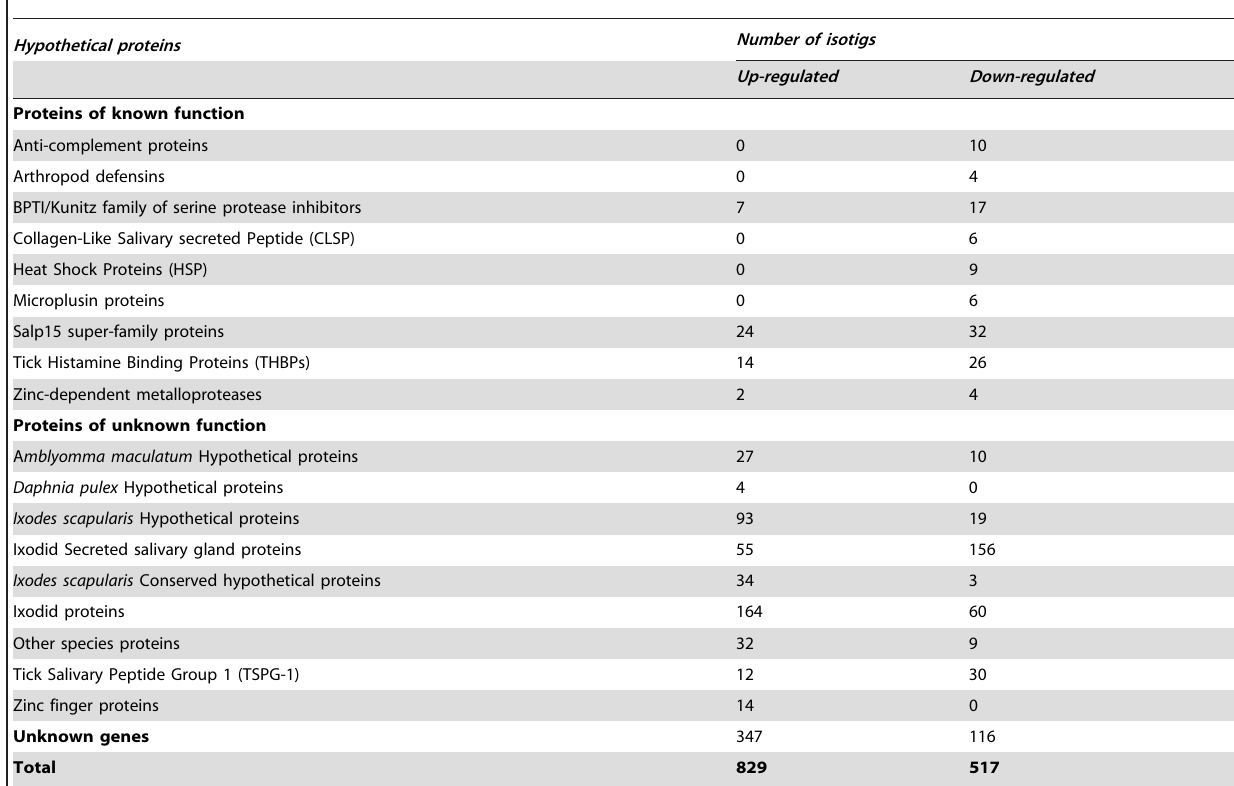
Table 3. Differentially expressed families of transcripts in B. henselae- infected I. ricinus female salivary glands compared to non- infected salivary